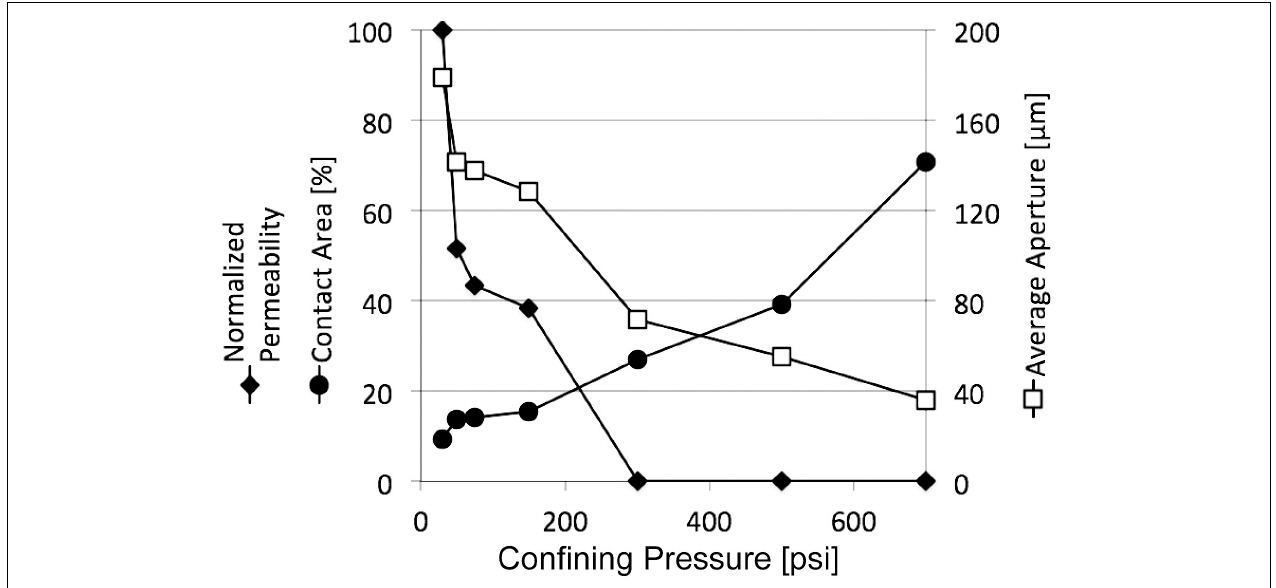
FIGURE 6 | Plots comparing hydraulic properties and morphometric parameters calculated for the fracture: normalized permeability [100 = value at the start of the experiment], asperity contacts area [%], and average aperture [ µ